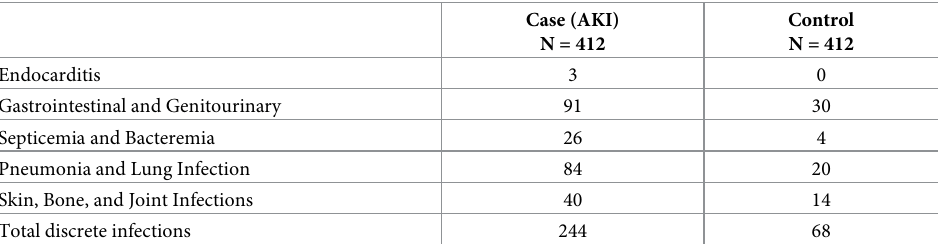
Table 3. Number of discrete infections among cases and controls by major infection category in the year after